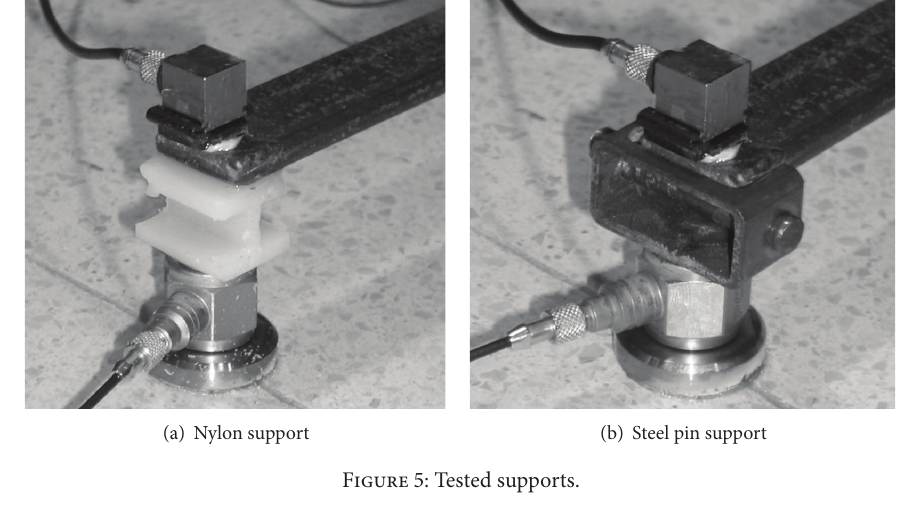
Figure 5: Tested supports.